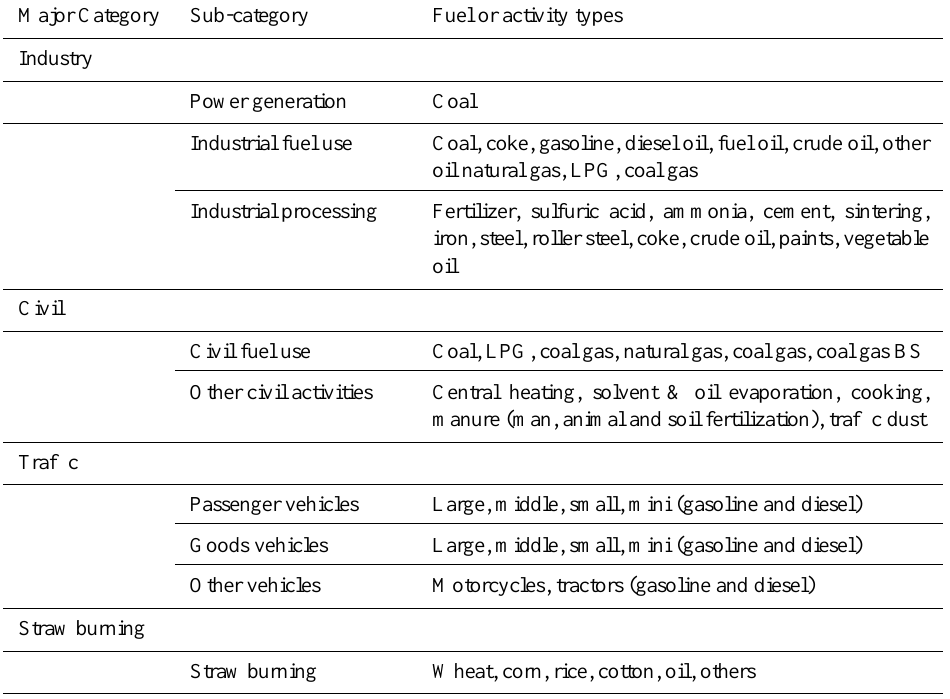
Table 3. Emission source categorization in the larger Huabei